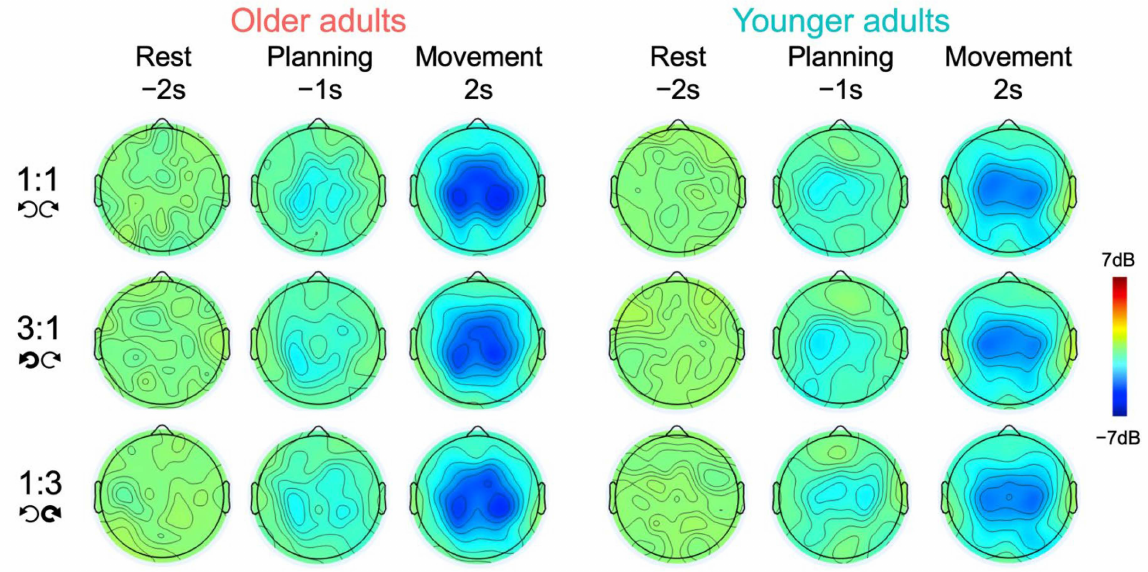
Figure 4. Topographic plots of spectral beta activity during rest, motor planning and execution in both older and younger adults for all three task conditions. The color scaling displays power ( − 7–7 dB), with blue colors reflecting movement-related beta